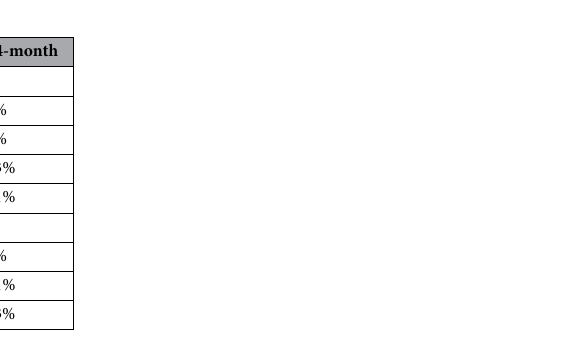
Figure 3. The Kaplan–Meier plot for recurrence free probability stratified by location of diverticulitis during follow-up.